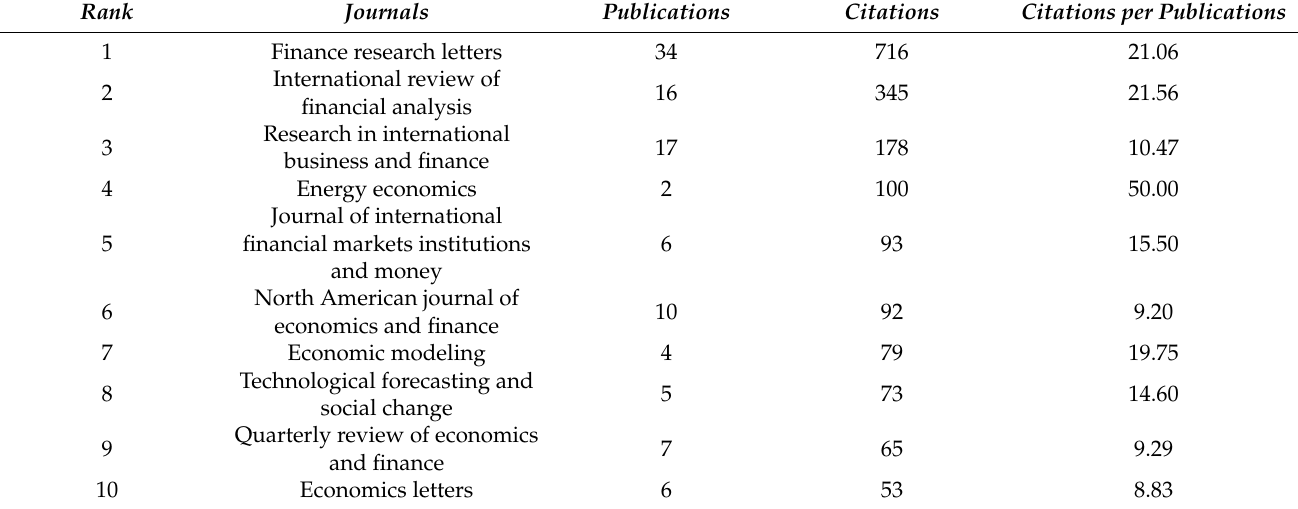
Table 4. Top 10 journals by number of